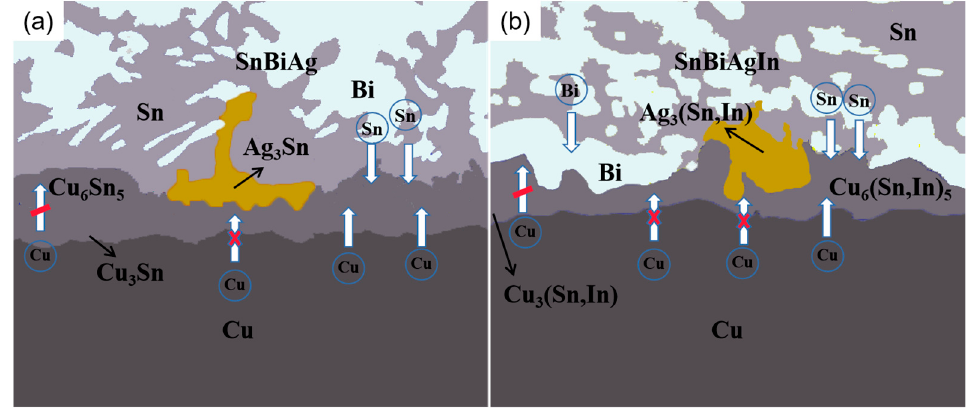
Figure 12. Schematic diagram of diffusion of elements in IMC during soldering: ( a ) SnBiAg; ( b ) SnBiAgIn.